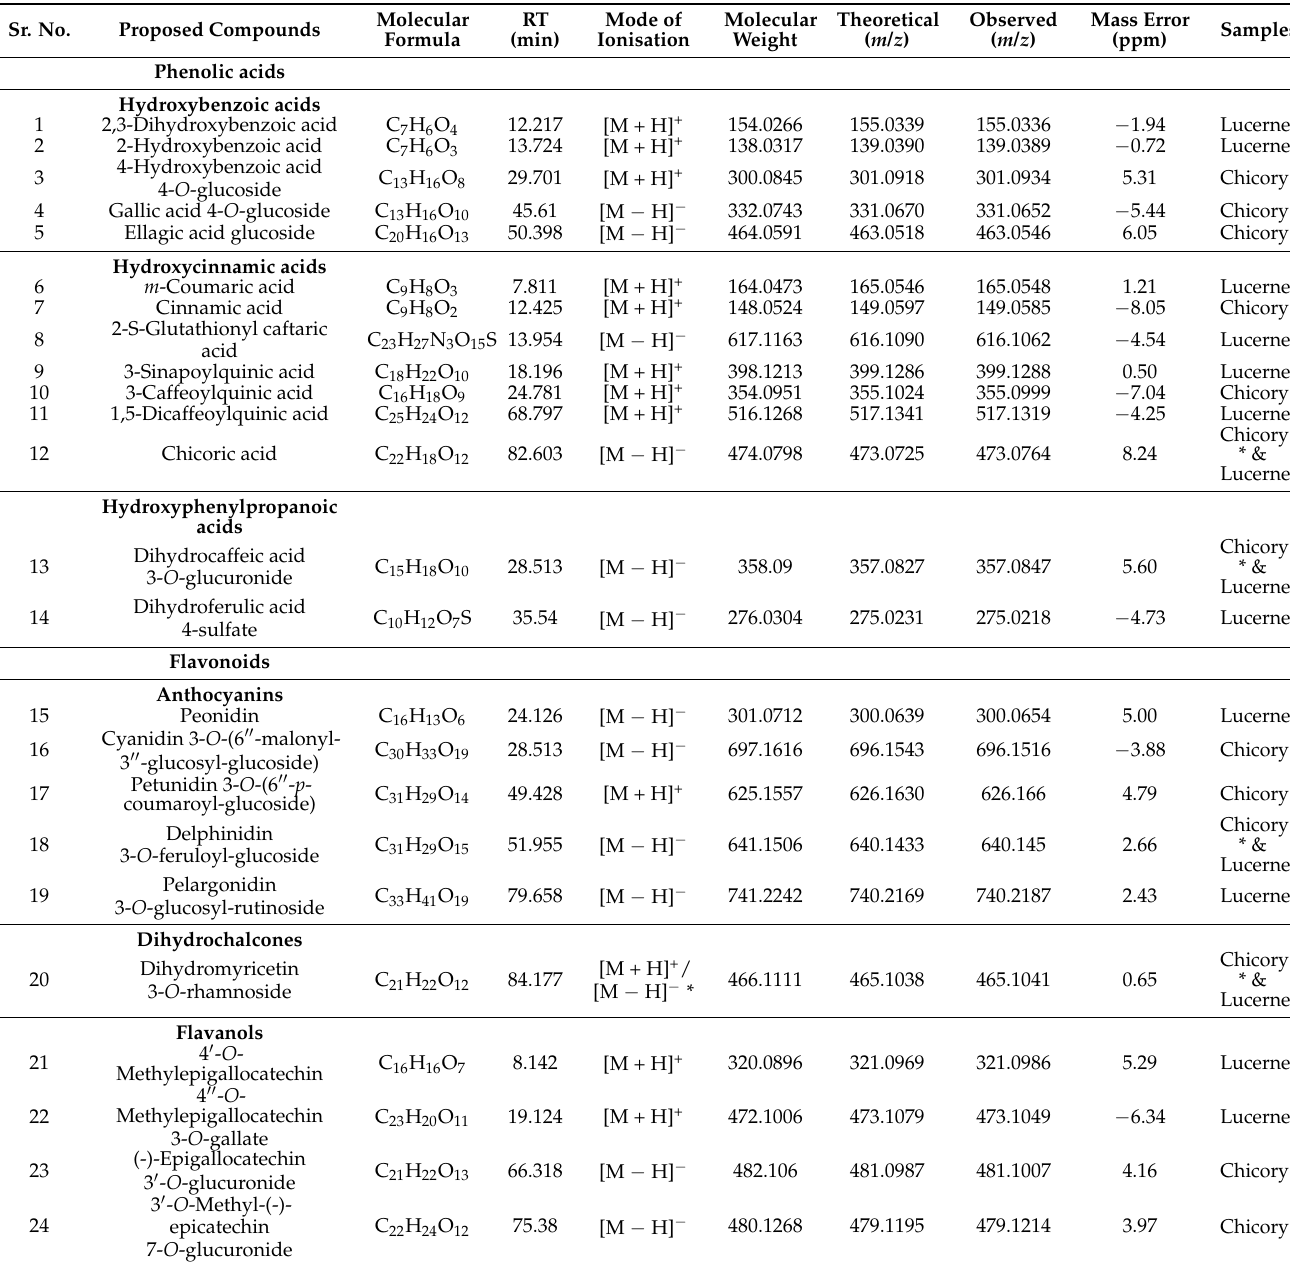
Table 3. Phenolic compounds detected and identified in chicory and lucerne by LC-ESI-QTOF-MS. Sr.